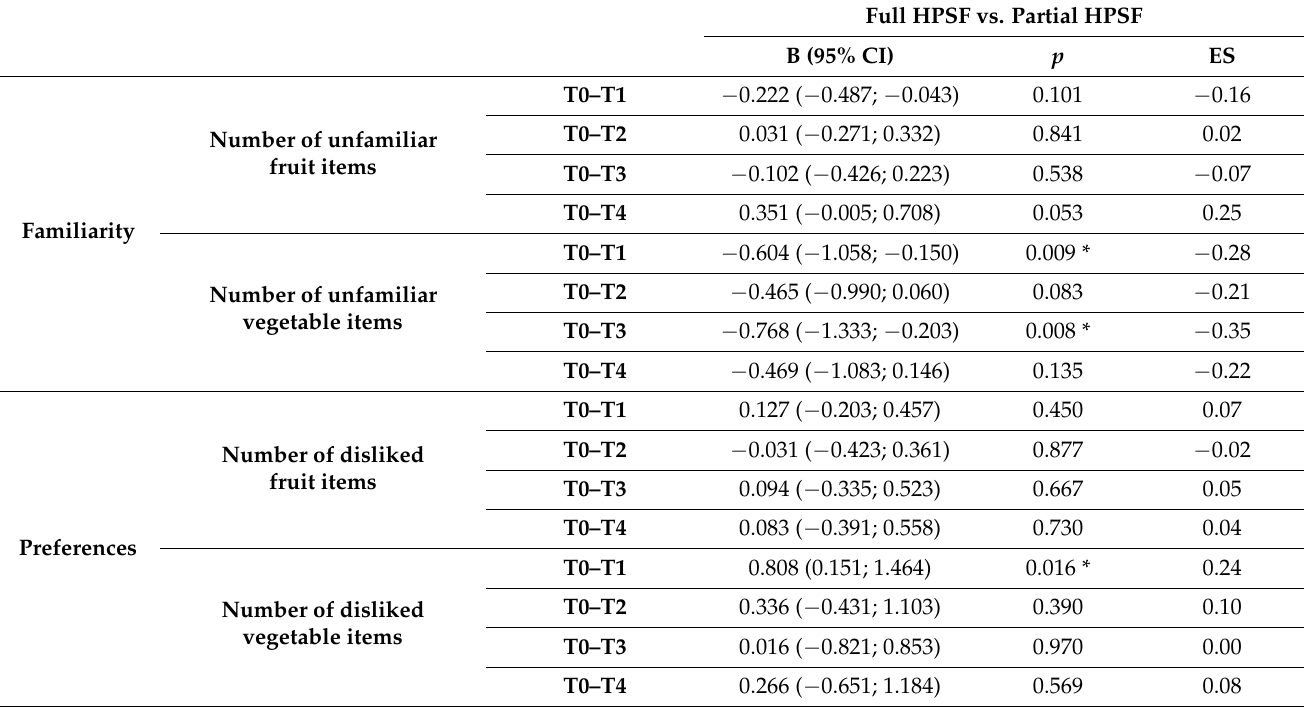
Table 4. Estimated intervention effects on fruit and vegetable familiarity and preferences.